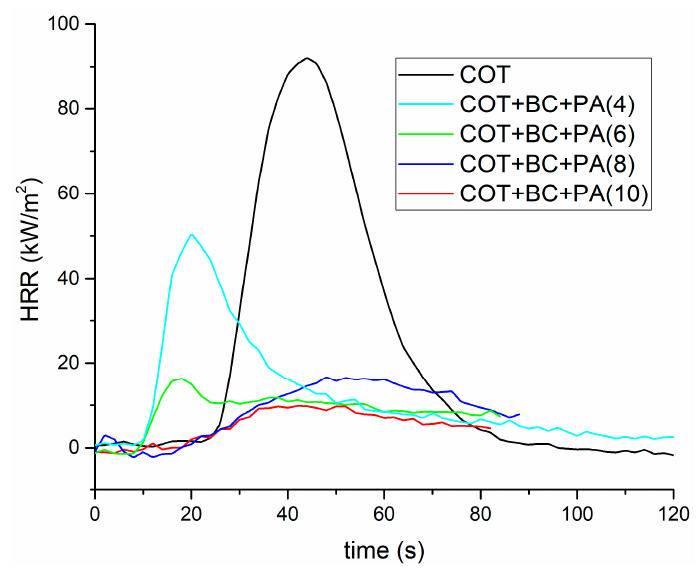
Figure 7. Heal Release Rate (HRR) vs. time curves for treated and untreated cotton fabrics (heat flux: 35 kW/m 2 ).